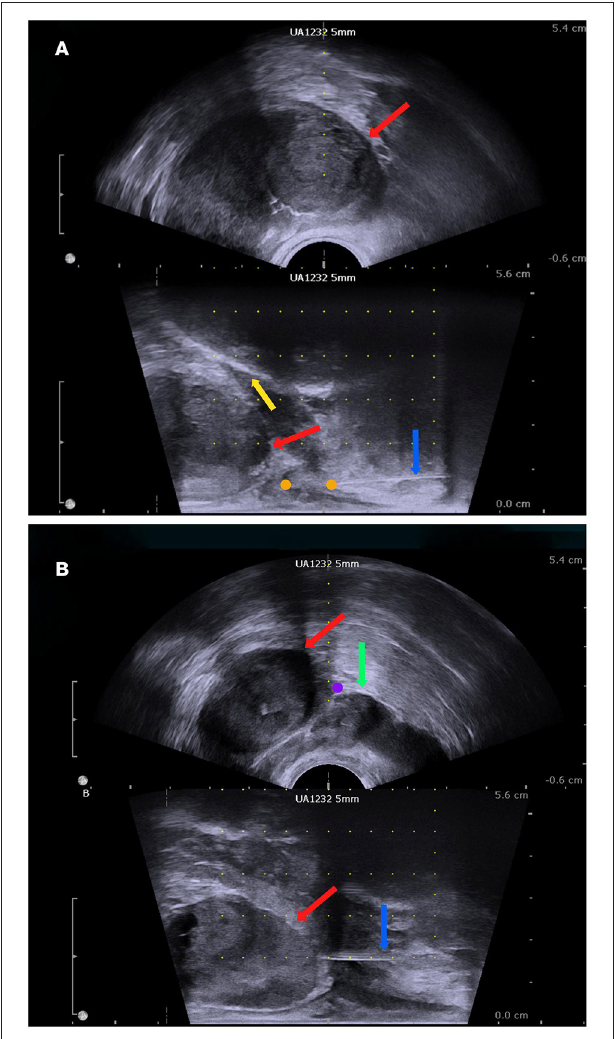
FIGURE 3 | The biplanar transrectal ultrasound image. (A) Perineal nerve block. (B) Periprostatic block: prostate (red arrow); pubis (yellow arrow); seminal vesicle (green arrow); anaesthesia needle (blue arrow); perineal nerve block site (orange dot); periprostatic site (purple dot).